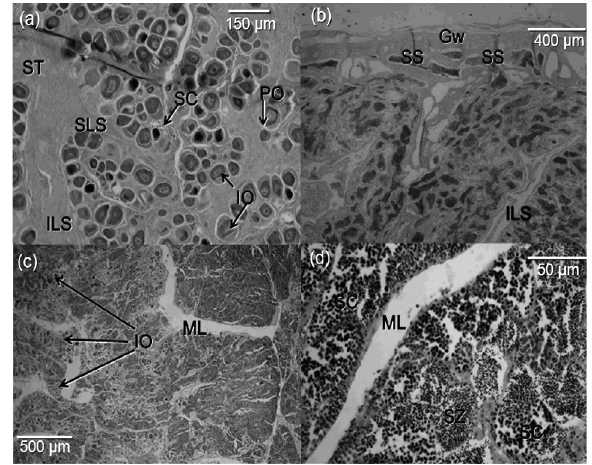
Fig . 4. – (a) Transverse section through a transitional gonad of Mycteroperca fusca showing primary oocytes, immature oocytes, and spermatocytes. (b) Transverse section through a teste of Mycter- operca fusca showing sperm sinus in the gonad wall. (c) Transverse section through a teste of Mycteroperca fusca showing immature oocytes and membrana-lined central cavities. (d) Transverse sec- tion through a teste of Mycteroperca fusca showing spermatocytes Fig . 3. – Transverse section through a resting ovary of Myctero- and spermatozoa. PO: primary oocytes, IO: immature oocytes, ML: perca fusca showing: (a) ovarian structure characterized by a central lumen and the lamellas, and (b) high-power view of primary oocytes and immature oocytes; (c) Transverse section through a ripening strand. SLS: Secondary lamellar stromal strand. ST: Stromal ovary of Mycteroperca fusca showing primary oocytes, immature oocytes and oocytes in primary vitellogenesis characterized by scattered vacuoles in cytoplasm around the nucleus. (d) Transverse section through a ripe and running ovary of Mycteroperca fusca showing late secondary vitellogenic oocytes, with well-defined yolk globules throughout the cytoplasm and showing several small nucleoli situated along the periphery of the nucleus and the zona radiata, and (e) mature oocyte. Transverse section through a spent ovary of Mycteroperca fusca showing: (f) primary oocytes, imma- ture oocytes and atretic vitellogenic oocytes. Lu: Lumen, L: lamel- las, PO: primary oocytes, IO: immature oocytes, PVO: oocytes in primary vitellogenesis, LSVO: late secondary vitellogenic oocytes, GV: germinal vesicle, OG: oil globule, YG: yolk globule, ZR: zona radiata. AO: atretic oocytes.